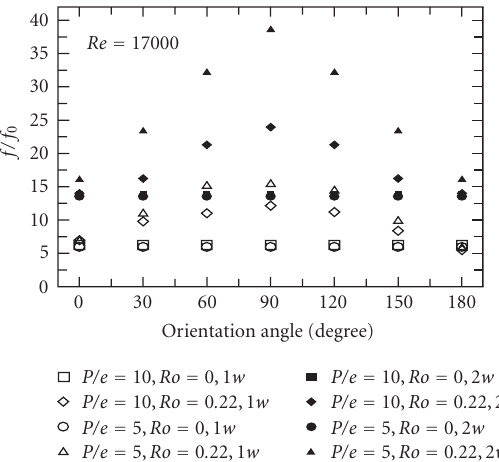
Figure 10: Comparison of friction factor ratios in square channel with detached ribs on one wall and two walls at Re =